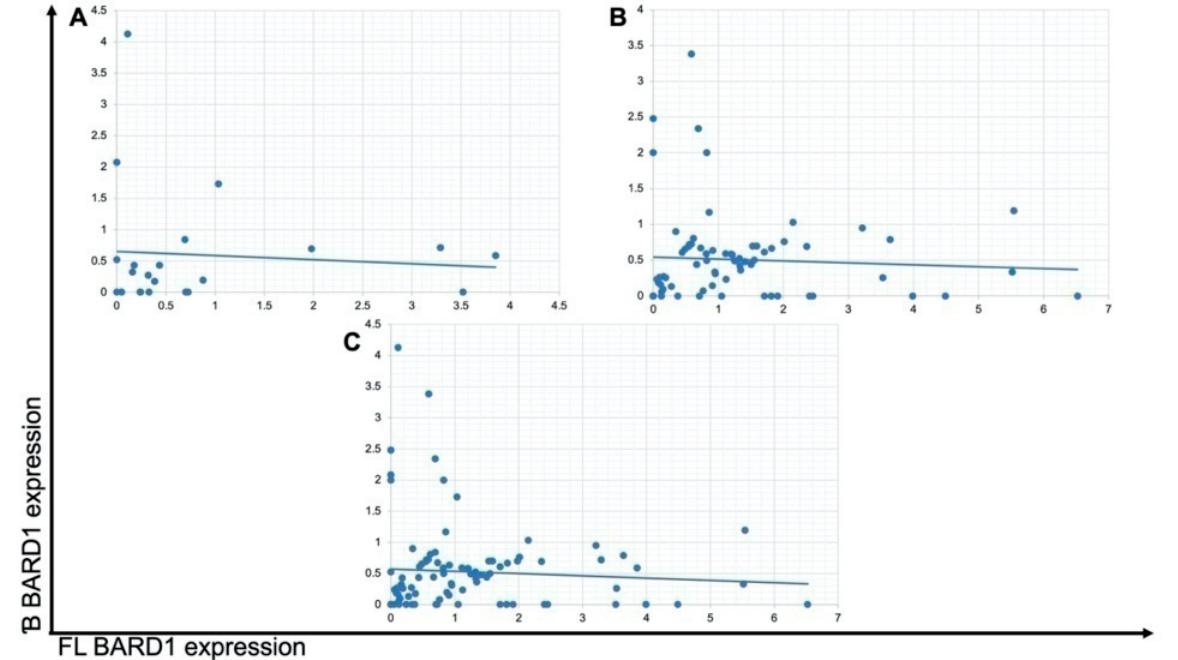
Figure 2. BARD1 FL and BARD1 β isoforms mRNA expression correlation. Neuroblastoma patients were divided into two groups based on the stage of the disease: ( A ) Connected stages 1 & 2 ( n = 19), ( B ) Stage 3, 4 & 5 ( n = 70) and ( C ) Patients’ data without stage division ( n = 89).